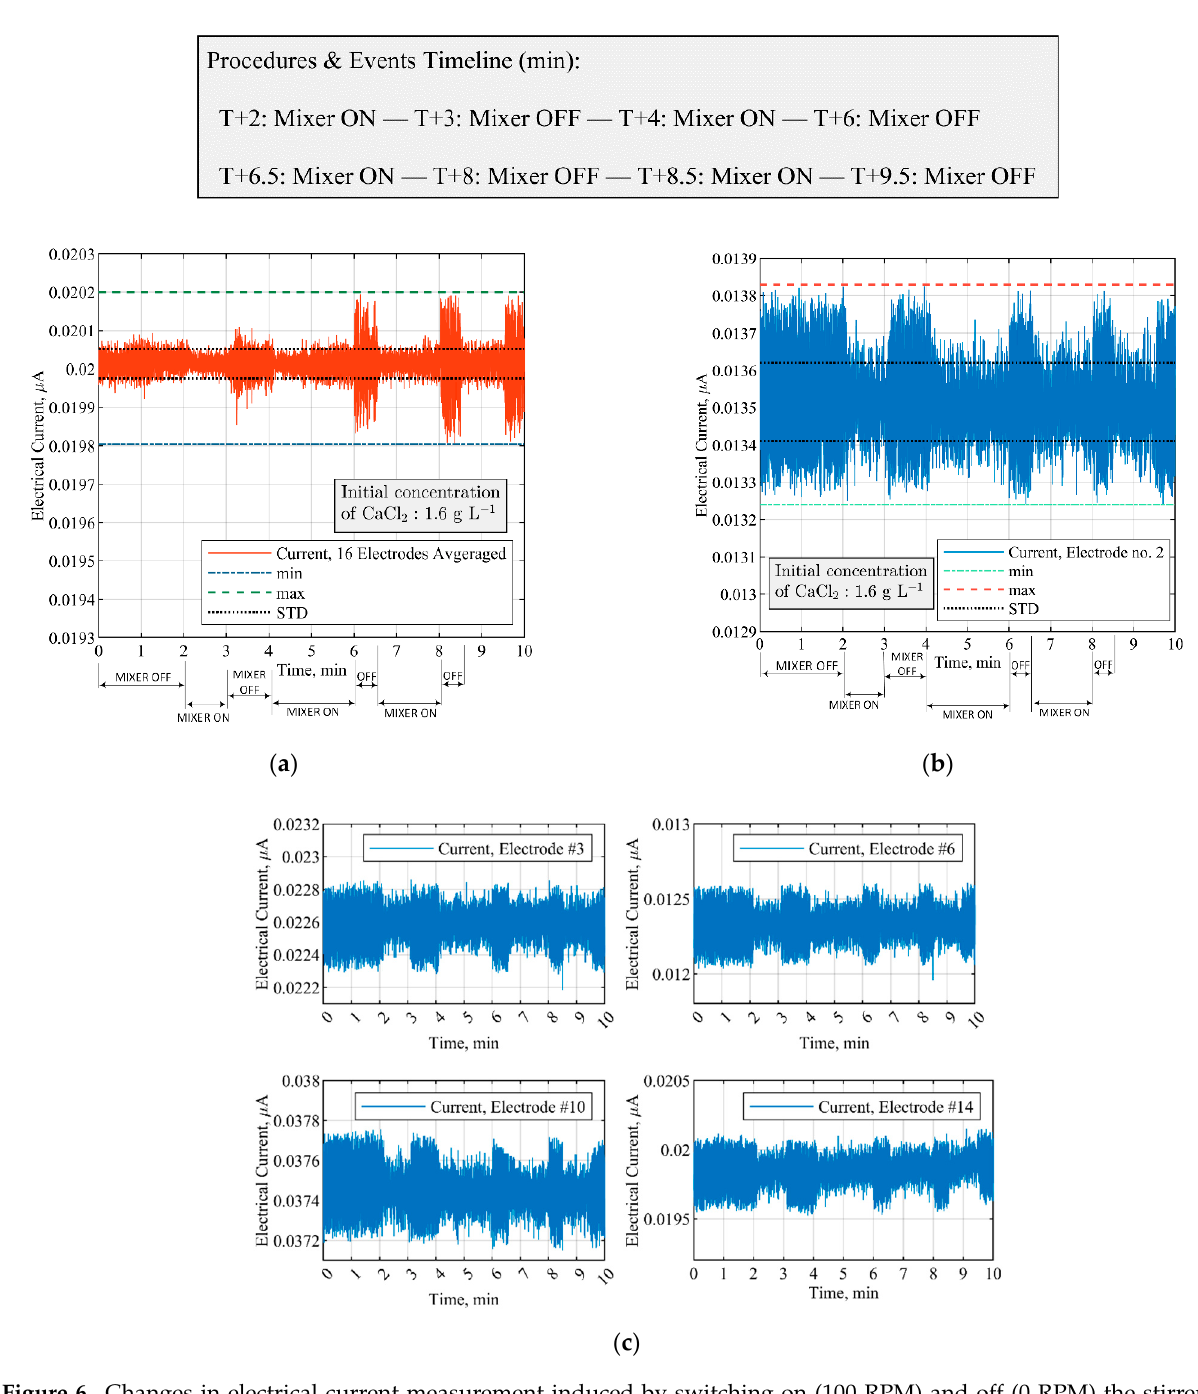
Figure 6. Changes in electrical current measurement induced by switching on (100 RPM) and off (0 RPM) the stirrer at CaCl 2 concentration of 1.6 g L − 1 , without any reagent addition. ( a ) Electrical current measurements by averaging 16 electrodes; ( b ) mixer-induced variation in the signals acquired through electrode no. 2; ( c ) comparison of electrical current measurements via single-electrode located at 90-deg apart inside the stirred tank reactor. Quantitative information from all the electrodes is reported in Appendix